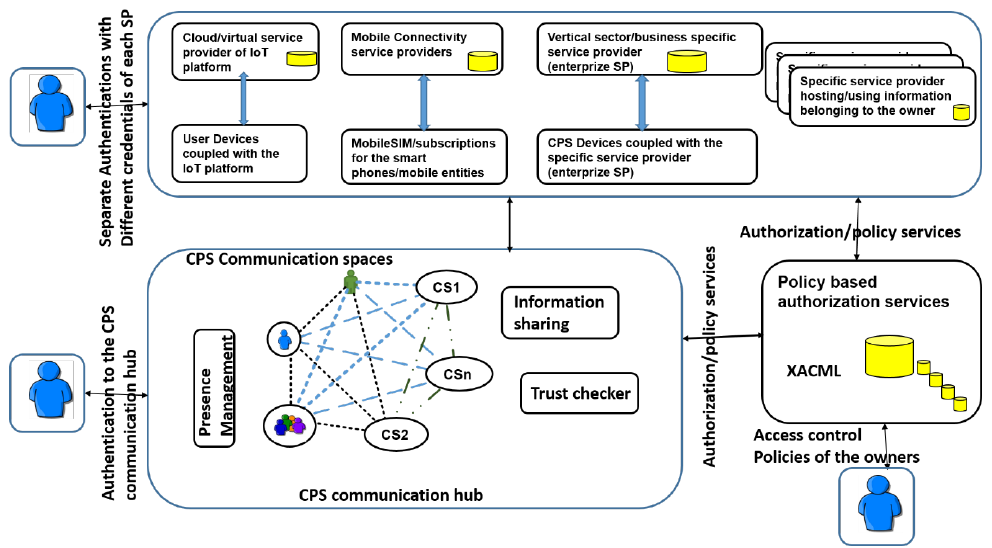
Figure 4. Trust checking with CPS communication spaces. IoT, Internet of Things; SP, service provider.